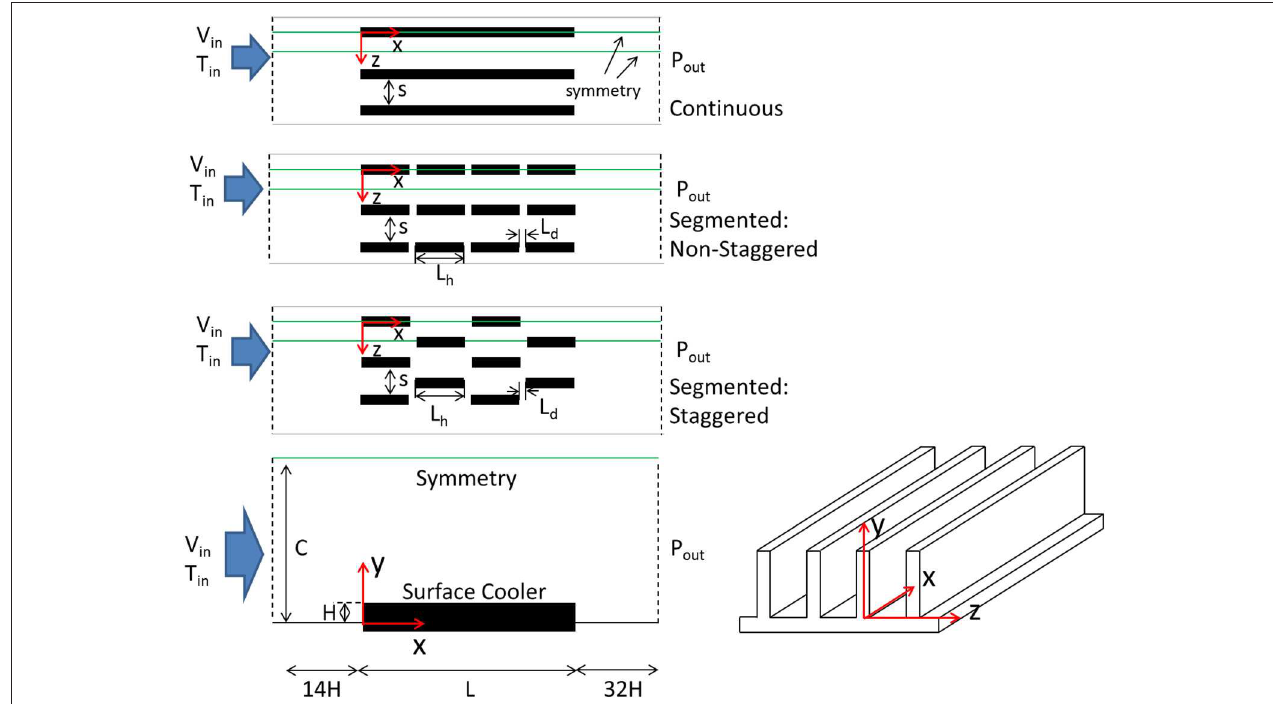
FIGURE 2 | Schematics of the surface coolers studied.